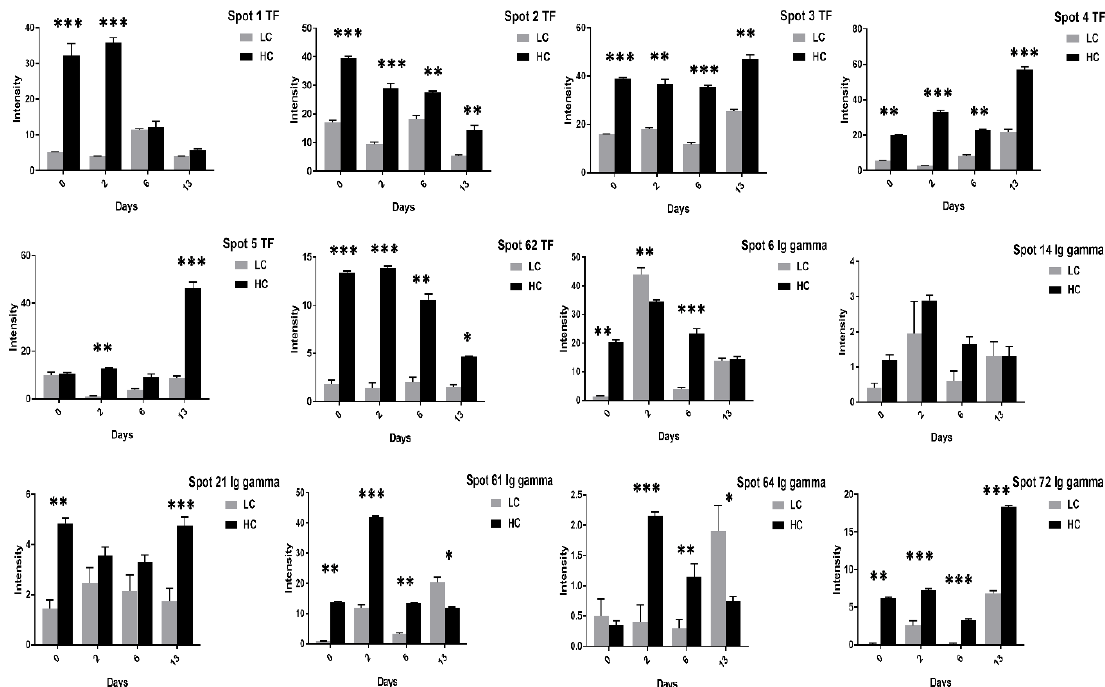
Figure 13. The TF and Ig gamma proteins spots comparative analysis was performed between low and high cholesterol eggs. The TF and Ig gamma spots showed significant differences at different incubation days. The data represent the mean values of three replicates and the error bars denote the standard deviation. * p < 0.05, ** p < 0.005, *** p < 0.0001.